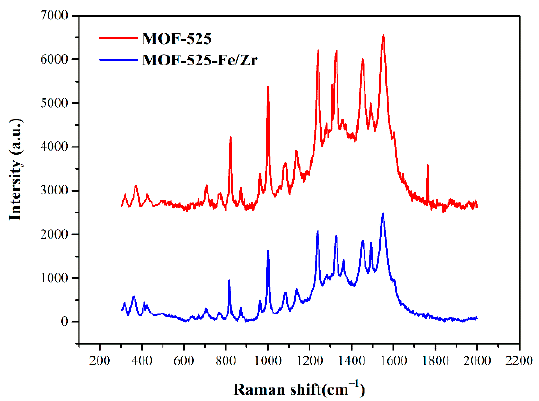
Figure 3. Raman spectra of MOF-525 and MOF-525-Fe/Zr.